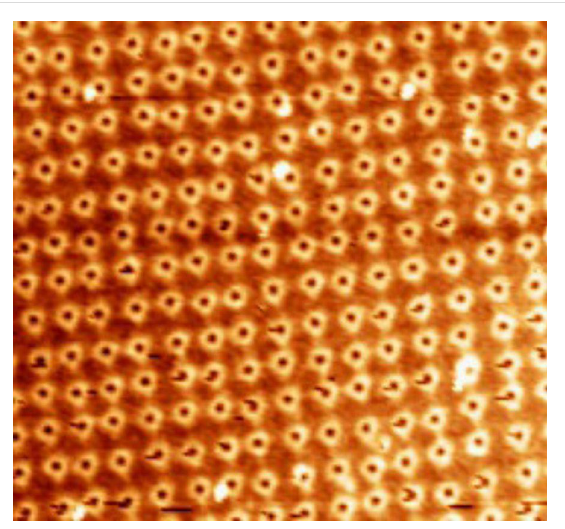
Figure 8: AFM image of nanopatterned surface exhibiting Si pits: Frame size: 3 µm.